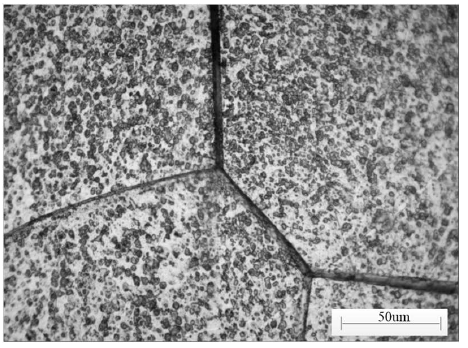
Figure 1. Optical microstructure of Fe-Cr-Co permanent magnet alloy. Table 1. Chemical composition of Fe-Cr-Co permanent magnet alloy (%). Table 1. Chemical composition of Fe-Cr-Co permanent magnet alloy (%).